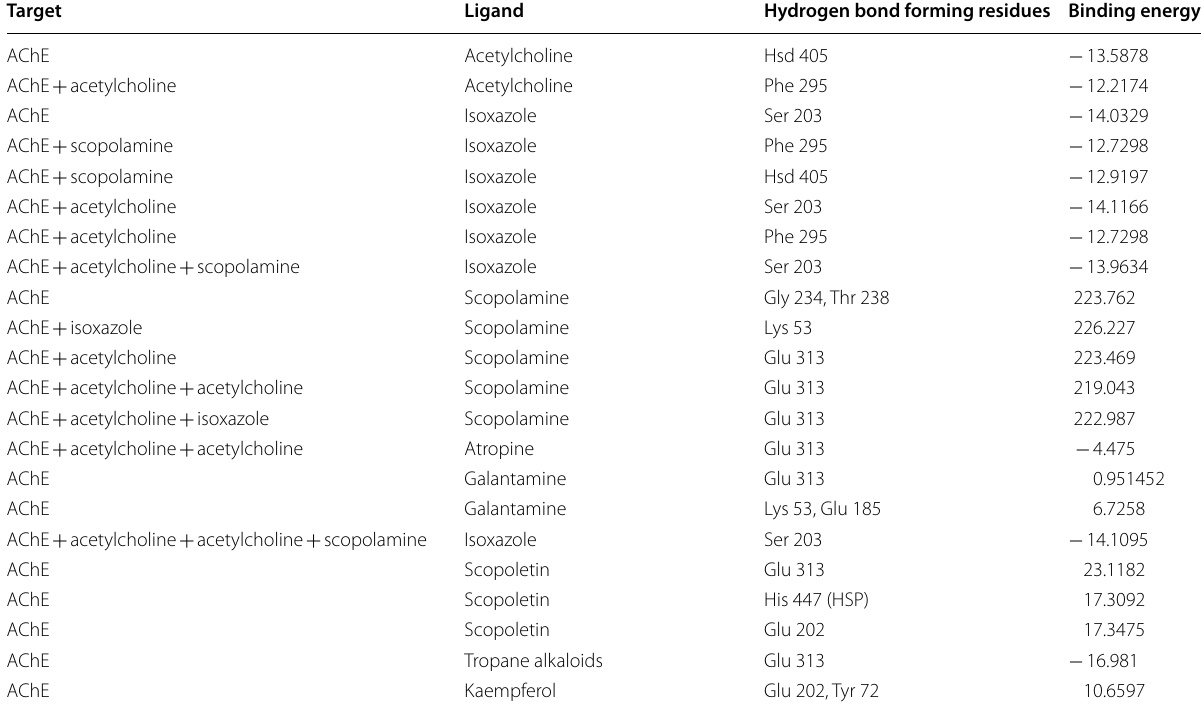
Table 1 Details on critical interactions of acetylcholinesterase with isoxazole, scopolamine and active components of Convolvulus pluricaulis , namely, scopoletin and kaempferol, and the central structure of scopoletin (tropane